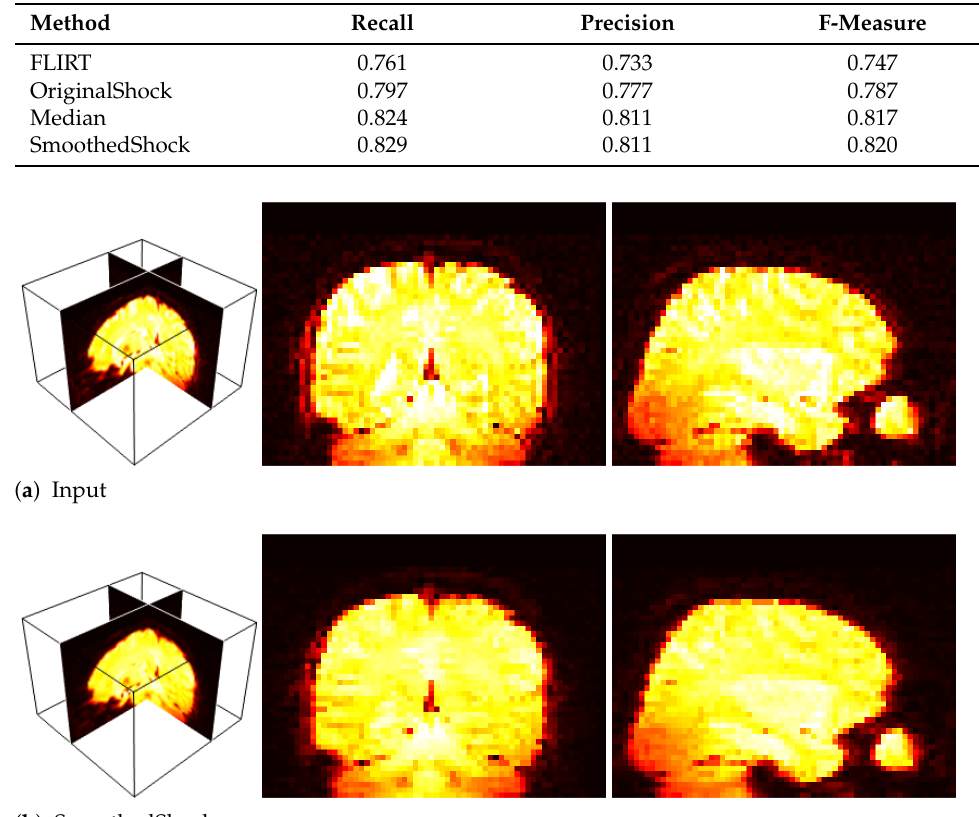
Figure 12. Filtering fMRI data: 3D view ( left ); and selected X and Y slices ( right